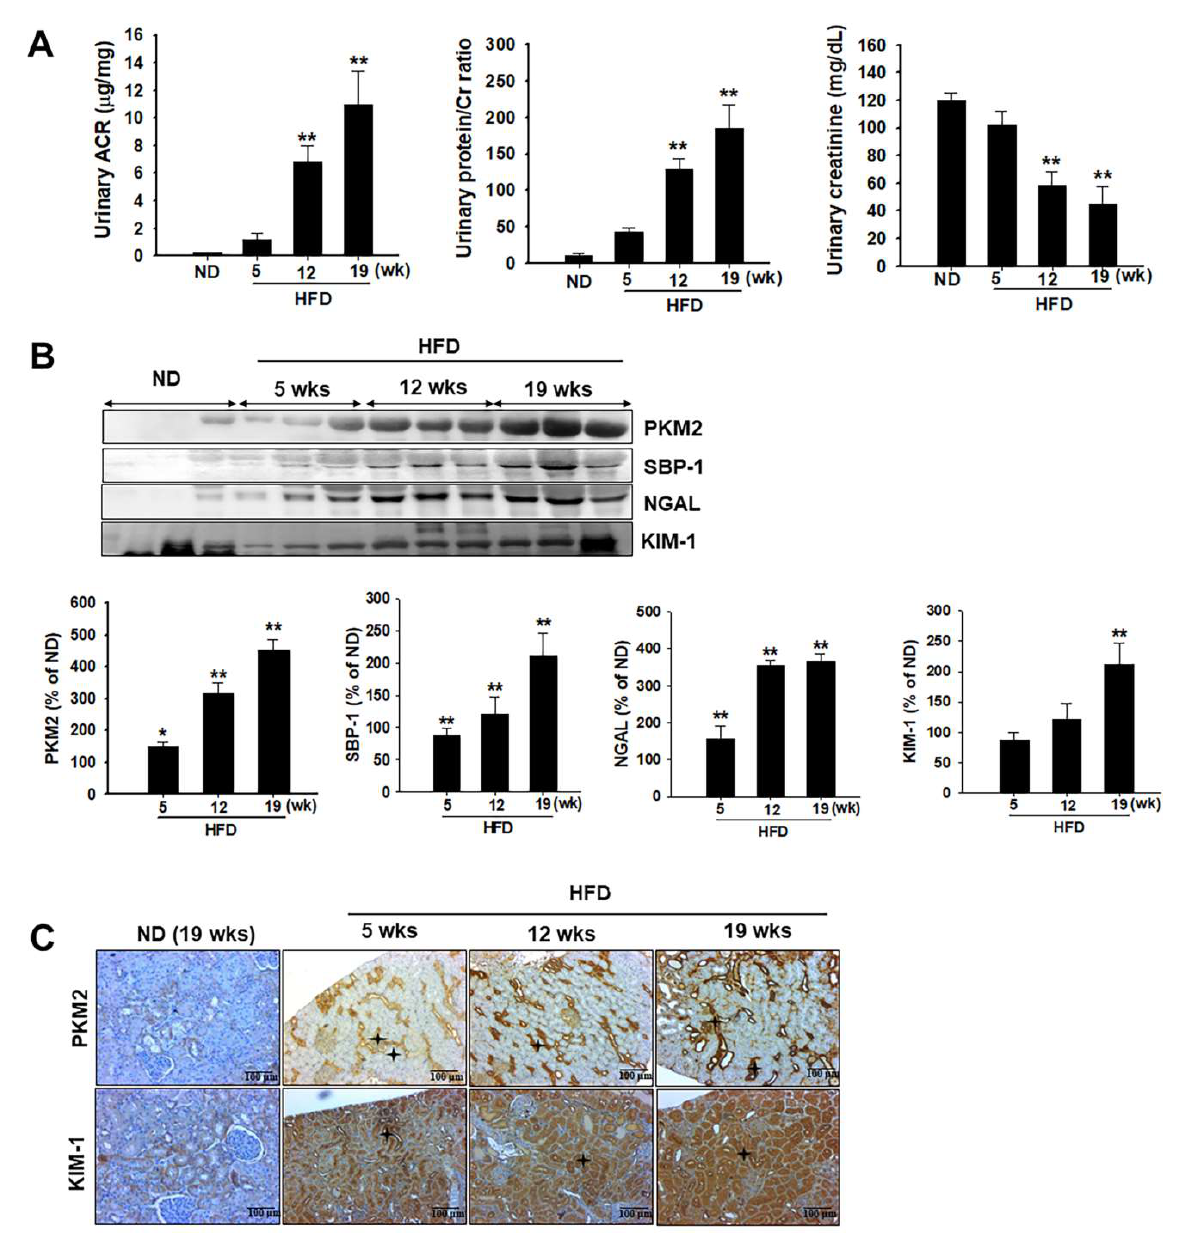
Figure 3. Effects of a high-fat diet (HFD) on urinary biochemical parameter changes. Zucker diabetic fatty (ZDF) rats were divided into two groups: (1) normal diet (ND) and (2) HFD groups. ( A ) Urinary albumin to creatinine (Cr) ratio, urinary protein to Cr ratio, and urinary Cr level were estimated at the indicated time points. ( B ) Urinary excretion of PKM2, SBP-1, NGAL, and KIM-1 levels were measured using western blot analysis. The semiquantitative levels of these biomarkers are indicated. Data are expressed as the mean ± standard deviation of each group. ** p < 0.01. ( C ) Representative immunohistochemical analysis of PKM2 and KIM-1 in the kidney of HFD-induced diabetic rats and normal diet-fed rats. * Black stars indicate PKM2 and KIM-1 expression in the damaged tubular tissues. ND, normal diet; HFD, high-fat diet.